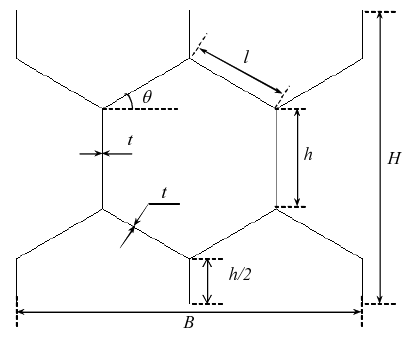
Figure 17. Unit model simulating an infinite